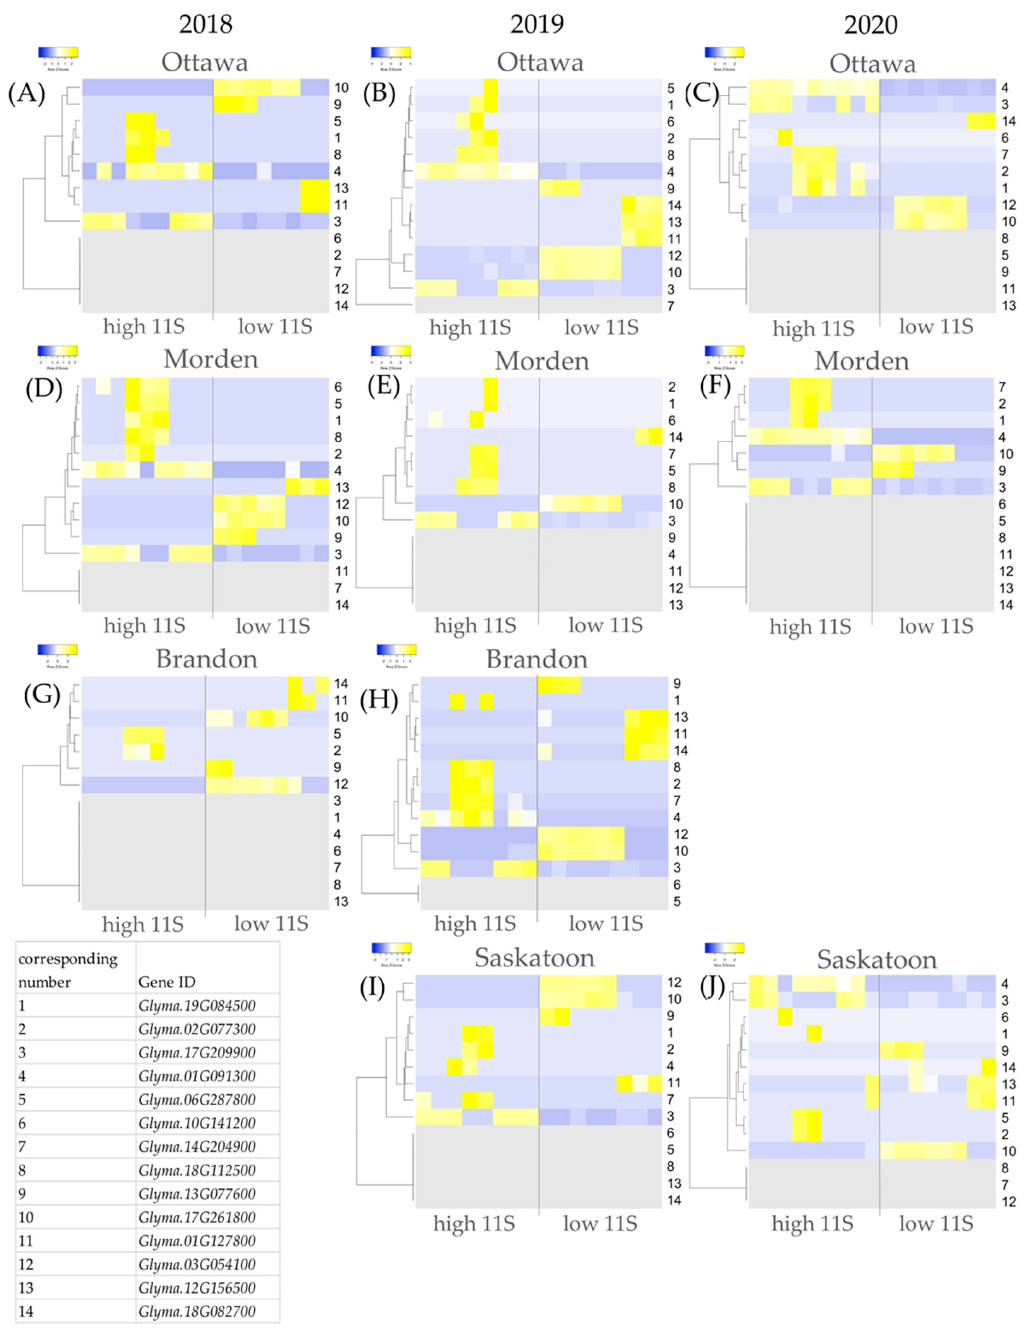
Figure 5. Expression heatmaps for shortlisted genes differentially expressed in high 11S soybeans (lines 2, 4, 8 vs. lines 1, 5, 9) for each year-location analysis. Each 11S year-location dataset is represented: ( A ) Ottawa 2018, ( B ) Ottawa 2019, ( C ) Ottawa 2020, ( D ) Morden 2018, ( E ) Morden 2019, ( F ) Morden 2020, ( G ) Brandon 2018, ( H ) Brandon 2019, ( I ) Saskatoon 2019, ( J ) Saskatoon 2020. Upregulation is indicated by shades of yellow, downregulation is indicated by shades of blue. Grey indicates that a gene was not differentially expressed between high and low 11S soybeans at an adjusted p -value < 0.05. The legend at the bottom left provides the gene identities and their correspond with the numbers on the right y-axis of the heatmaps. Glyma.17G261800 was also downregulated in 7/10 DE datasets between high vs. low TP soybeans (Table 3); log2FC DE ranged from − 15.0 (Brandon 2018; Figure 5G)